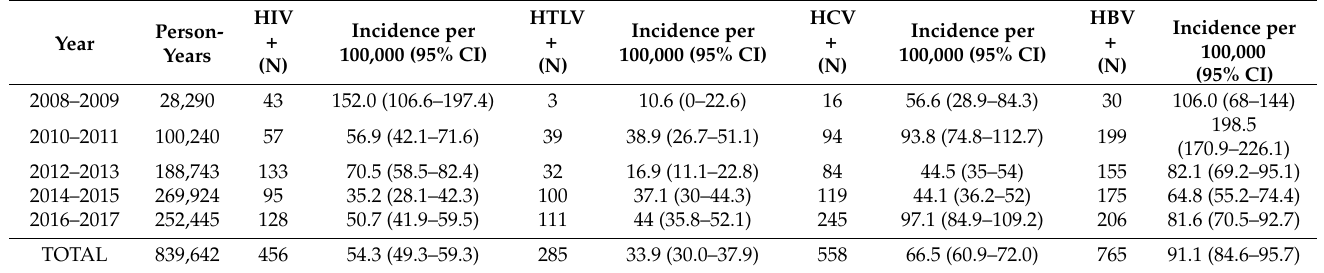
Table 7. Incidence Density rates (95% CI) of HIV, HTLV, HCV and HBV infection in Hemoba